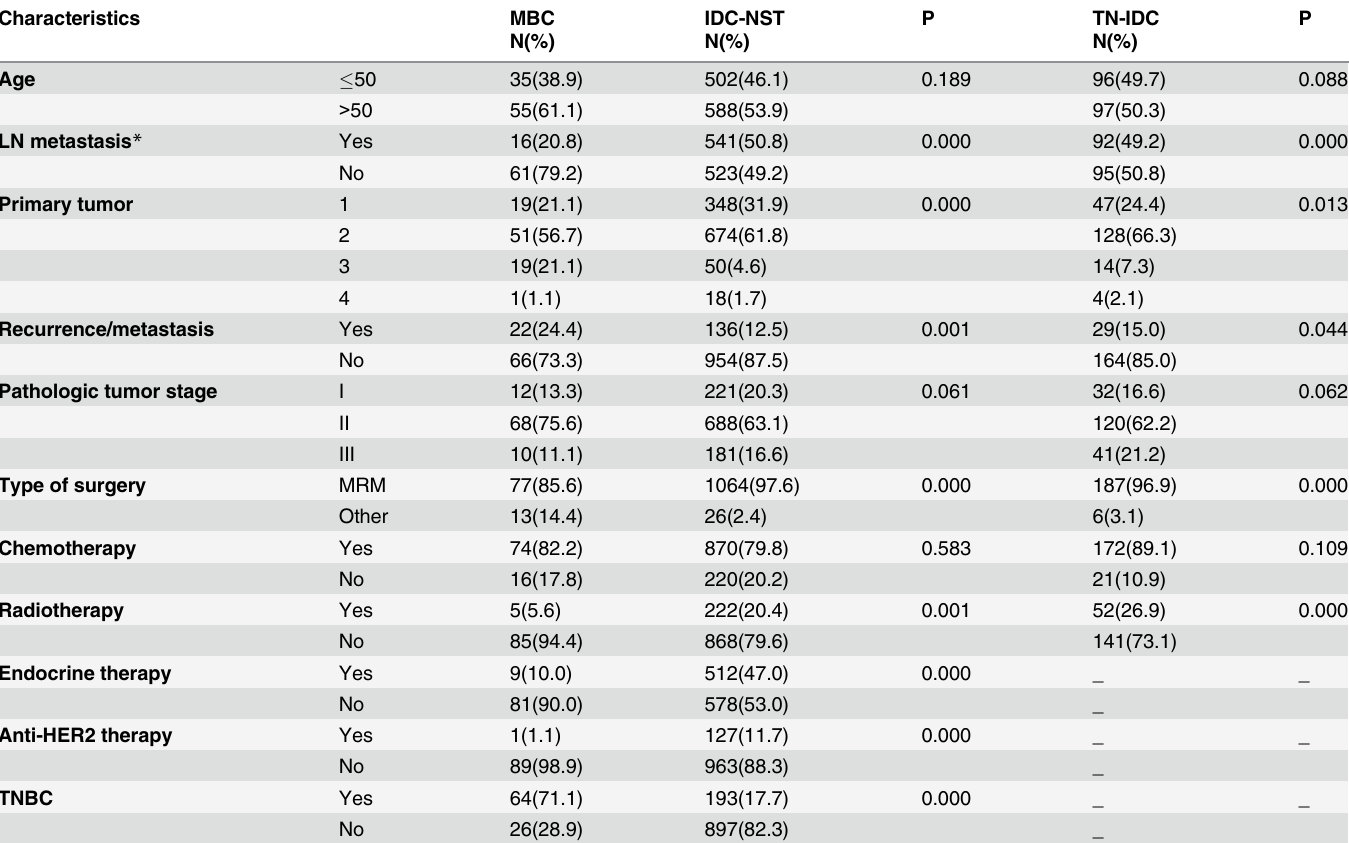
Table 1. Clinicopathological features of MBC, IDC-NST and TN-IDC.